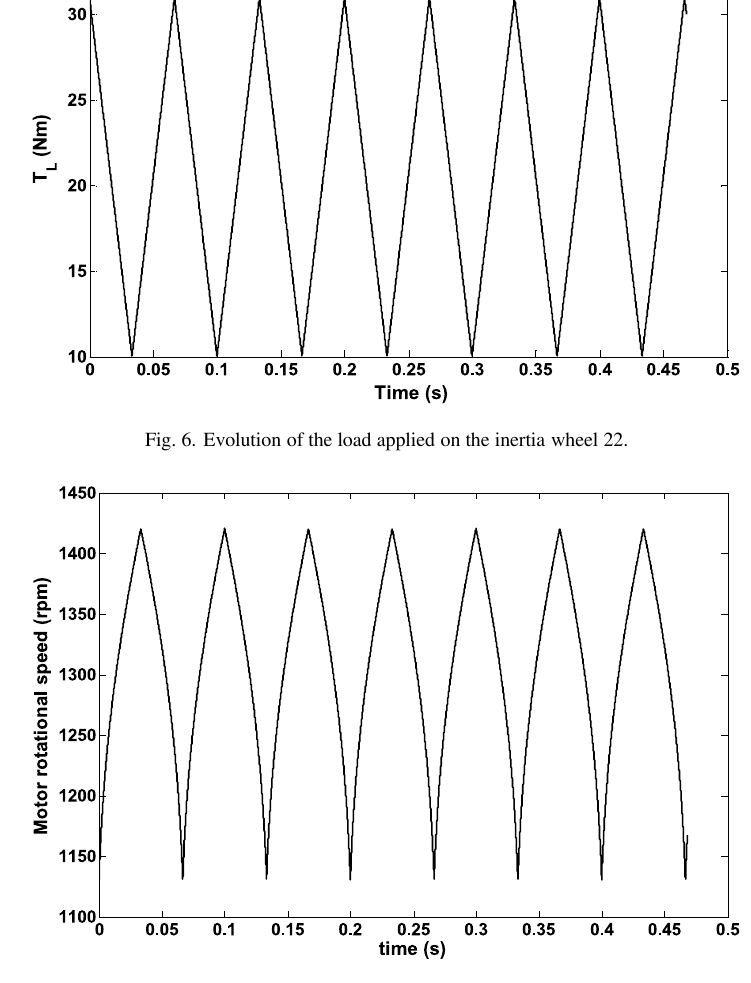
Fig. 7. Variation of the motor rotational